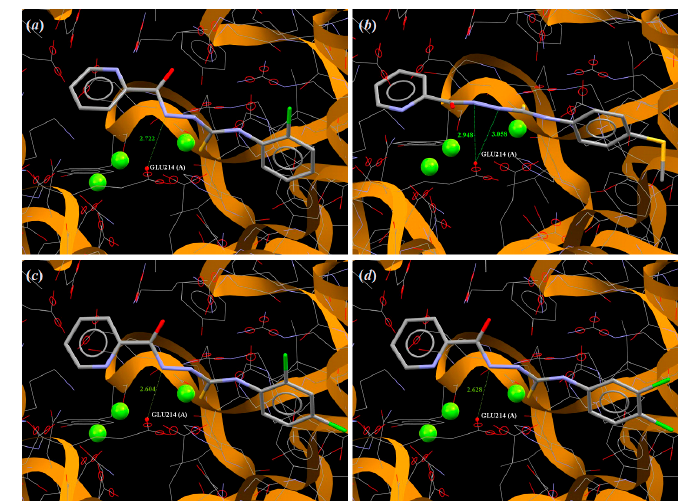
Figure 5. A view of the interaction between ( a ) 2 , ( b ) 3 , ( c ) 4 and ( d ) 5 and the binding site of MtGS e.